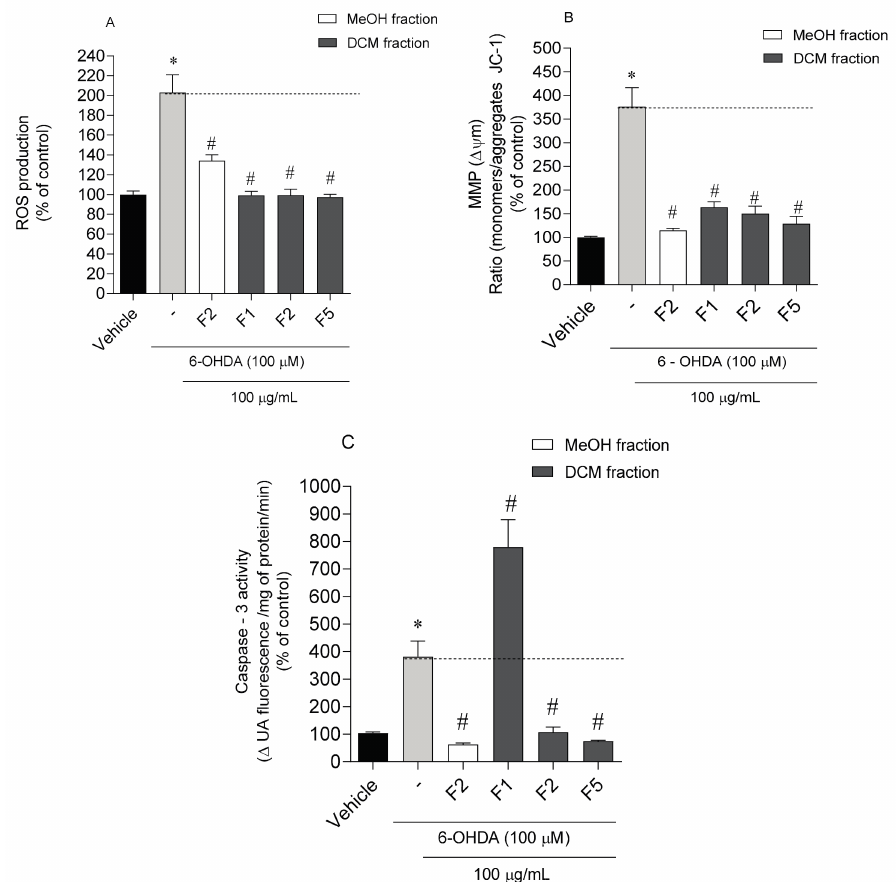
Figure 3. PD hallmarks evaluation on SH-SY5Y cells when exposed to 6-OHDA (100 µ M) and Codium tomentosum fractions (100 µ g / mL; 6 h). ( A ) ROS production; ( B ) changes in mitochondrial membrane potential; ( C ) Caspase-3 activity. (-) 6-OHDA. The values in each column represent the mean ± standard error of the mean (SEM) of three or four independent experiments. Symbols represent significant di ff erences (ANOVA, Dunnett’s test, p < 0.05) when compared to: * vehicle and #